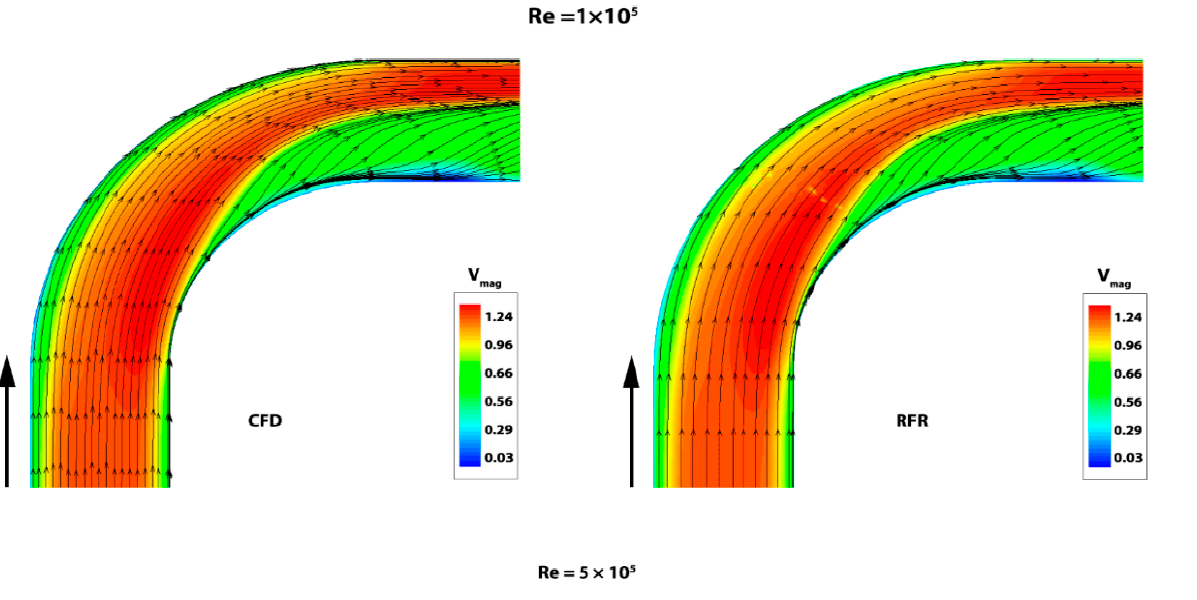
Figure 8. Flow structure at bend outlet ( θ = 90°) of the bend for different Re. ( left section : CFD result; right section : RFR result). Figure 8 depicts the time-averaged in-plane velocity magnitude normalised with the inlet velocity ( V mag ) at the bend outlet section ( θ = 90°), similar to Figure 7. The contour plot of V mag is shown on the left side of each picture, along with the streamlines plot of mean secondary flow from the current CFD simulations. The outside wall of the bend is at the top of each image, while the inner wall is at the bottom. Supreme velocity is ob- served in the upper and centre regions of the bend cross section, while a low velocity area